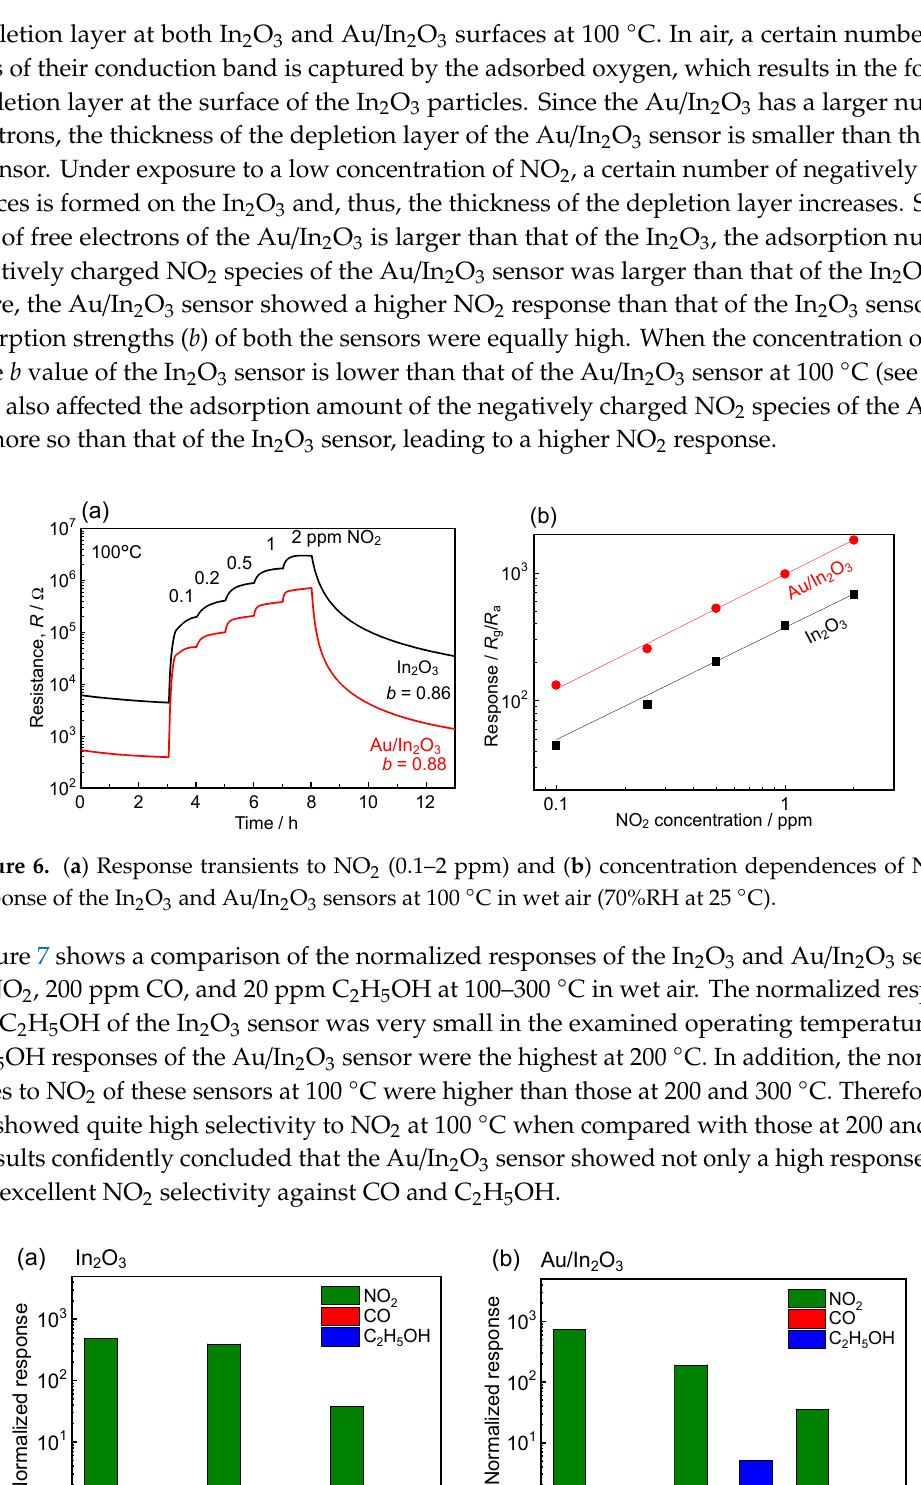
Figure 7. Comparison of normalized responses to 5 ppm NO 2 , 200 ppm CO, and 20 ppm C 2 H 5 OH of the ( a ) In 2 O 3 and ( b ) Au/In 2 O 3 sensors at 100, 200, and 300 °C in wet air (70%RH at 25 °C).